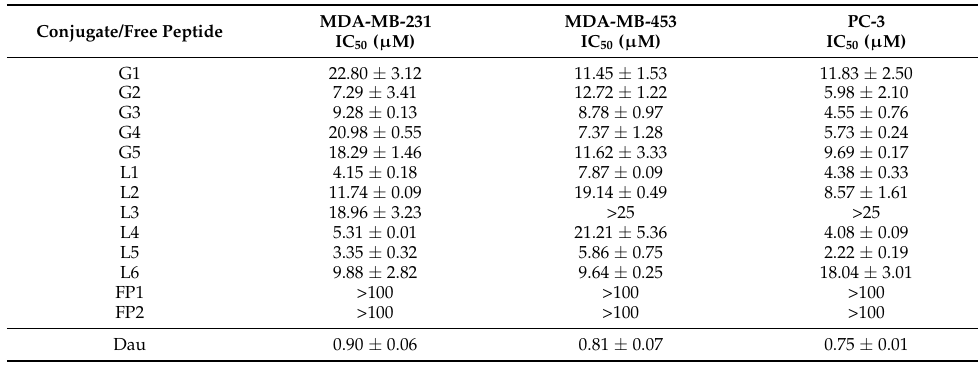
Table 2. IC 50 values related to the cytostatic effect of the Dau–BBN (7-14) conjugates and the free peptides on human breast cancer MDA-MB-231 and MDA-MB-453, and human prostate cancer PC-3 cell lines. All values are reported as mean ± SD (n =